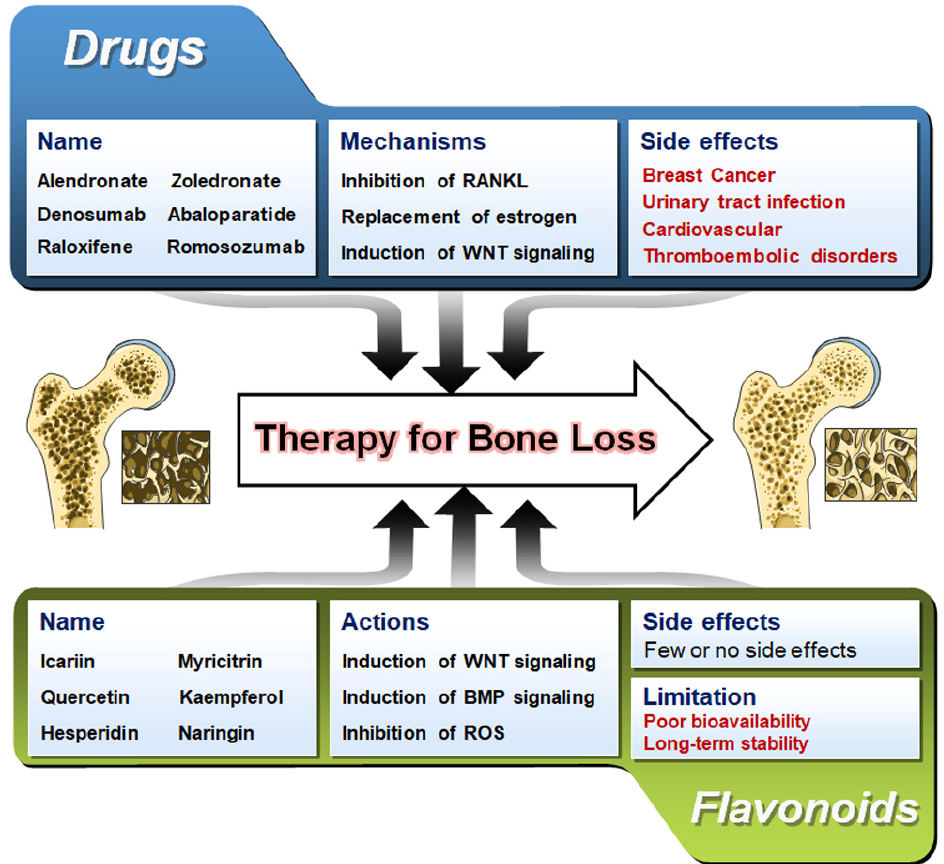
Figure 6. A comparison of flavonoids and available pharmaceutical drugs in treating bone loss. Bone images are taken from Servier Medical Art (https://smart.servier.com accessed on 07 February 2023) which is licensed under a Creative Commons Attribution 3.0 Unported License (Suresnes, France). Table 4. Clinical trial studies of flavonoids for treating bone loss.